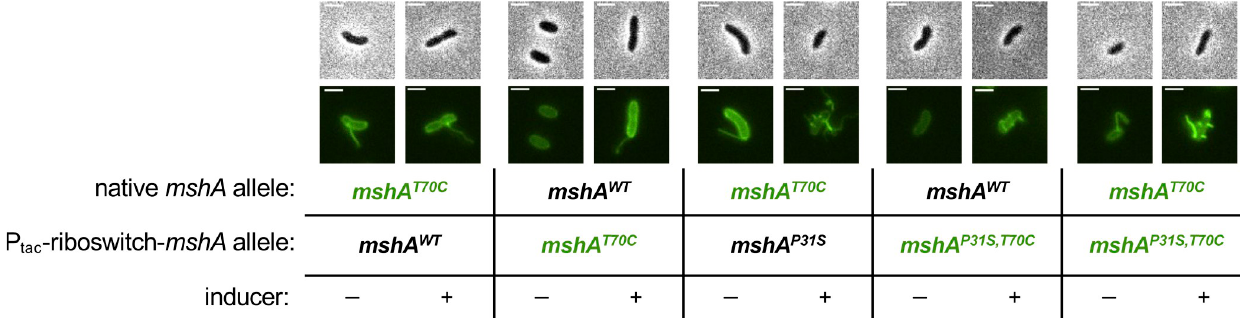
Fig 7. The MshA P31S suppressor allele promotes assembly of wild-type MshA. Representative images of cells from Δ pilT strains expressing the indicated mshA allele at the native locus (native mshA allele) and ectopic locus (P tac -riboswitch- mshA allele). Cells were either grown with (”+”) or without (”-”) 100 μ M IPTG + 1.5 mM theophylline to induce the ectopic P tac -riboswitch- mshA allele in the strain as indicated. Only the alleles containing the T70C mutation can be labeled with AF488-mal and are denoted in green text in the table below the images. Lookup tables are equivalent between fluorescent images to reflect the expression level of the labelable mshA allele. Scale bar = 2 μ m.